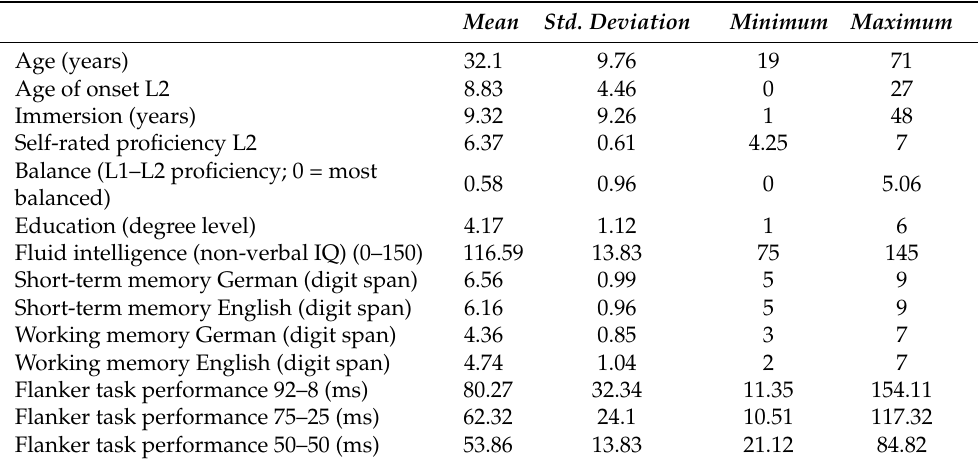
Table 5. Background variables describing bilingual